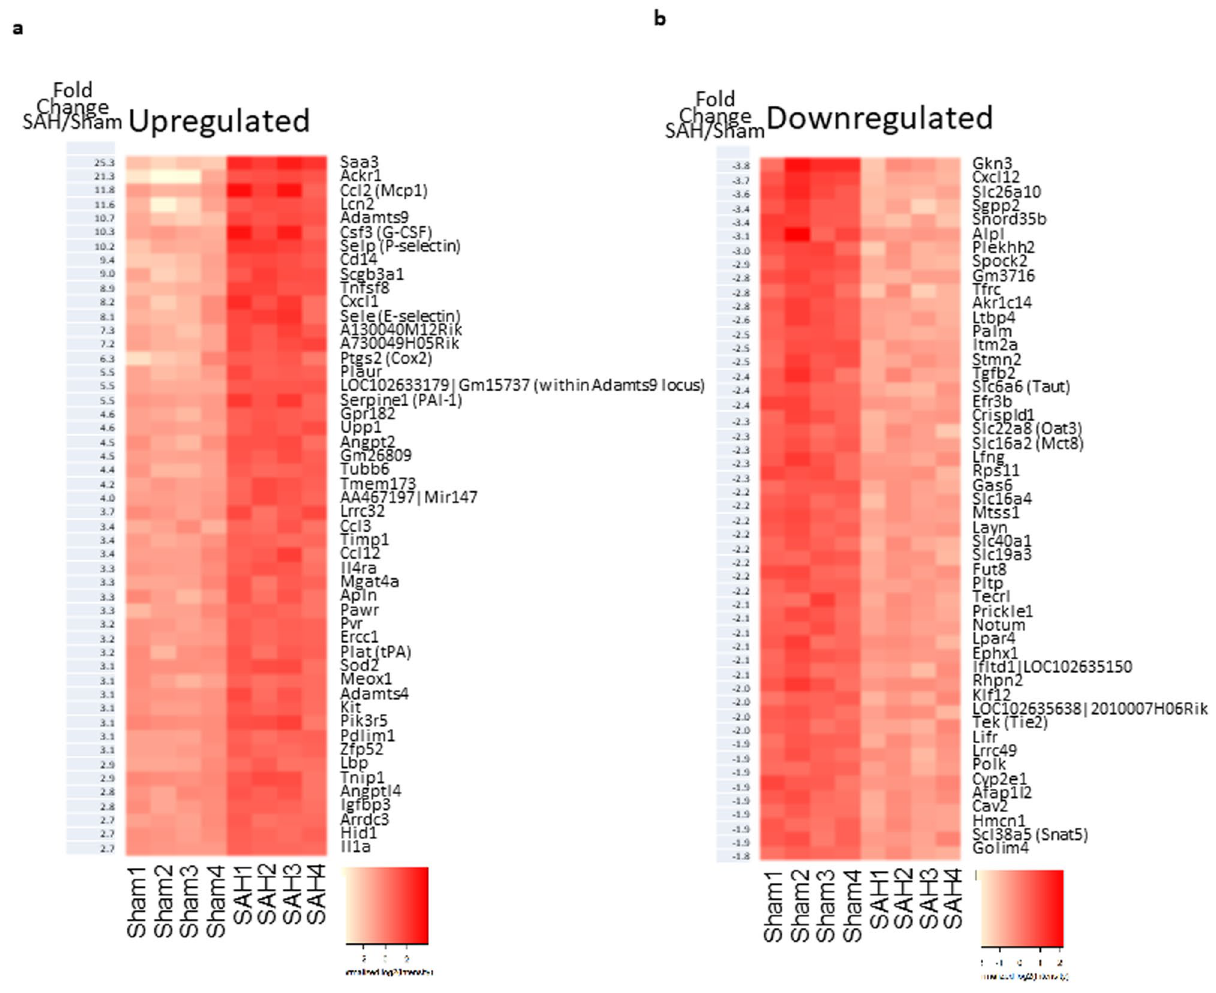
Figure 5. Differentially expressed genes. ( a ) The 50 highest ranked genes based on upregulation in CD45– CD31 + BECs after SAH. ( b ) The 50 highest ranked genes based on downregulation in CD45–CD31 + BECs after SAH. n = 4 per